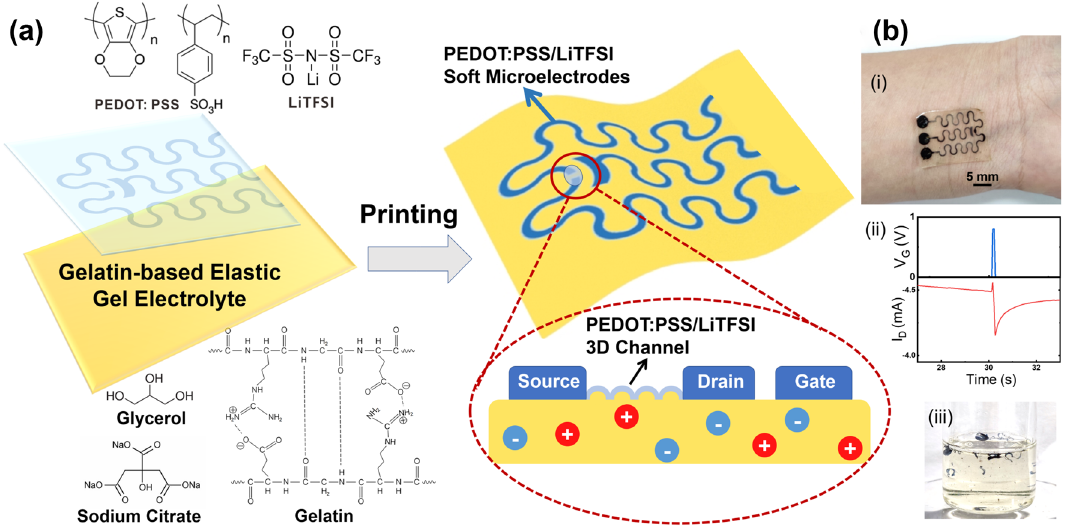
Fig. 1 a Schematic diagram of substrate-free all-polymer organic electrochemical transistor (OECT) utilizing gelatin-glycerol/sodium citrate (GEL-GLY/Na 3 Cit) organohydrogel electrolyte as the elastic substrate, and PEDOT:PSS/LiTFSI as both the soft electrodes and the active chan- nel layer with 3D micro-engineered interface. b Images show that the printed all-polymer OECT can be body-attachable (i), synapse-mimicking with slower current recovery after a voltage spike (ii), and readily recyclable with water